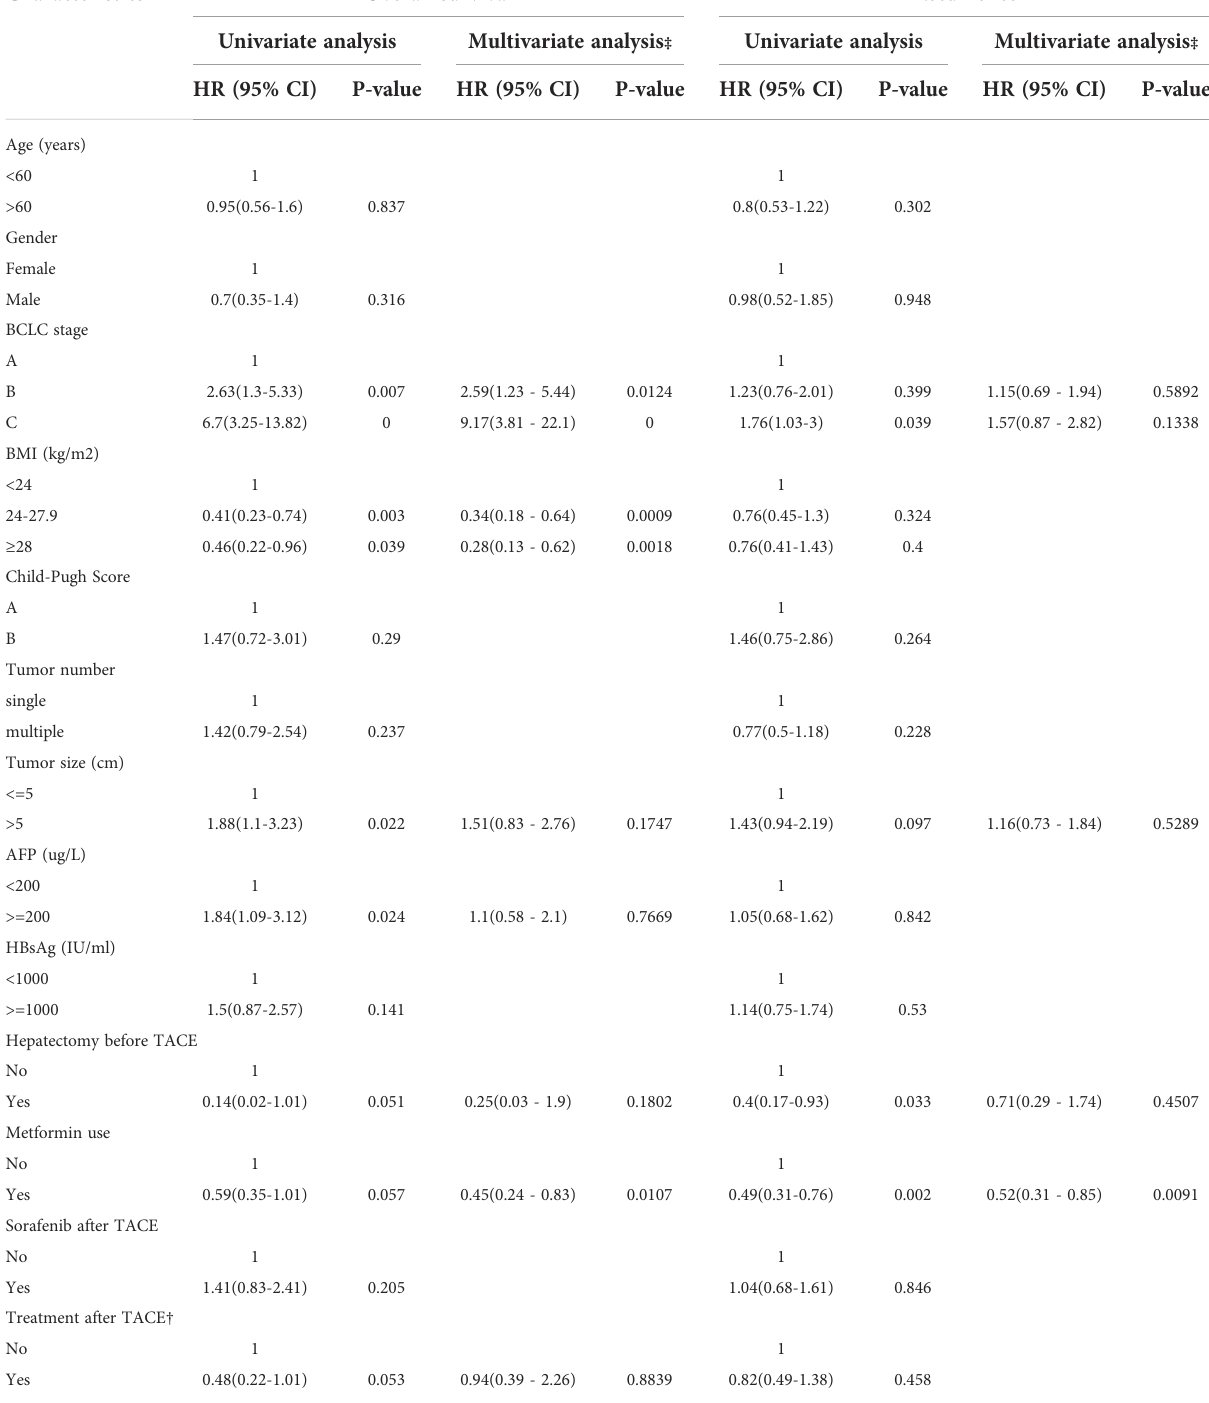
TABLE 2 Univariate and multivariate competing risk regression analysis for Overall survival and recurrence in the whole